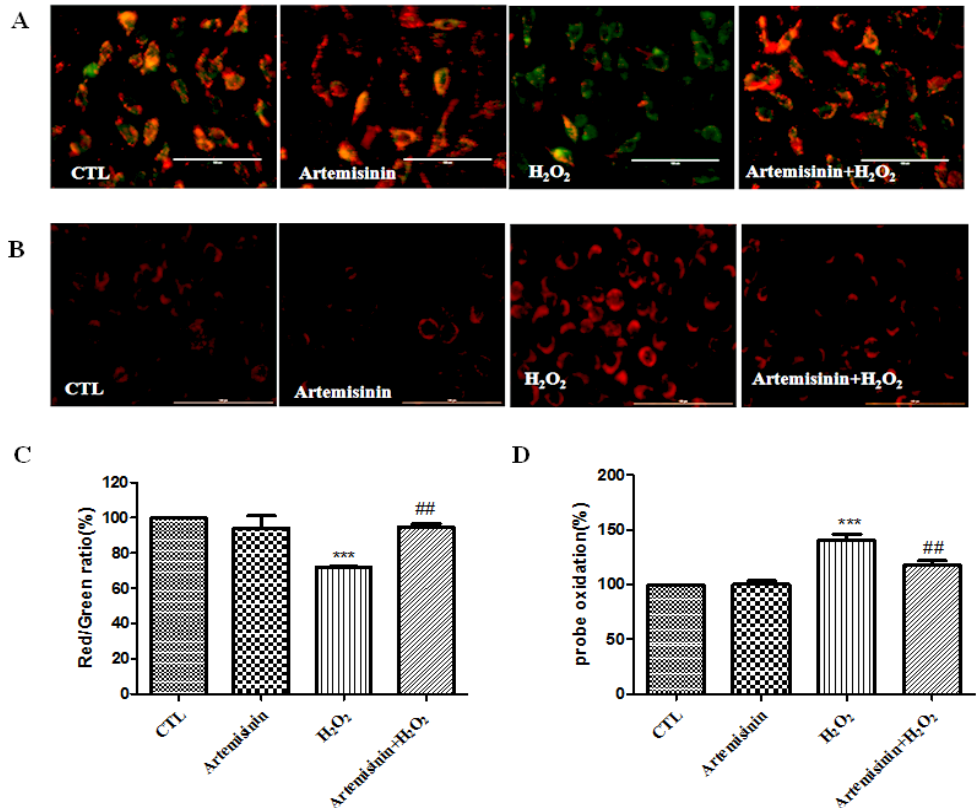
Figure 3. Artemisinin inhibited H 2 O 2 -induced increase of reactive oxygen species (ROS) level and restored the mitochondrial membrane potential in SH-SY5Y cells. ( A ). After pre-treatment with 12.5 µ M artemisinin or 0.1% DMSO (vehicle control) for 2 h, SH-SY5Y cells were incubated with or without 600 µ M H 2 O 2 for another 24 h. The decline in the membrane potential was reflected by the shift of fluorescence from red to green indicated by JC-1. The pictures have been taken at a magnification of 40 × (100 µ m). ( B ). Intracellular ROS level was measured by the CellROXs Deep Red Reagent. The pictures has been taken on 40 × (100 µ m). ( C ). Quantitative analysis of ( A ). ( D ). Quantitative analysis of ( B ). The data were represented as the mean ± SD of three independent experiments. *** p < 0.001, ## p < 0.01.